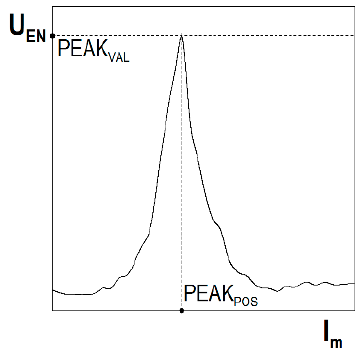
Figure 12. Characteristic quantities of the envelope.